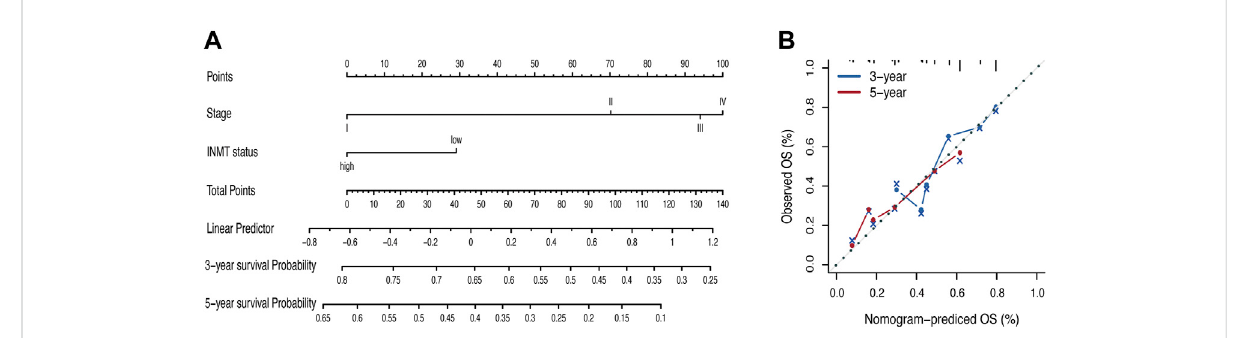
FIGURE 4 Nomogram for the prediction of survival in LUAD. (A) Nomogram by multivariate Cox regression analysis for predicting the proportion of patientswithoverallsurvival(OS). (B) PlotsdepictthecalibrationofthemodelintermsoftheagreementbetweenpredictedandobservedOS.Model performance is shown by the plot, relative to the 45-degree line, which represents perfect prediction. OS, overall